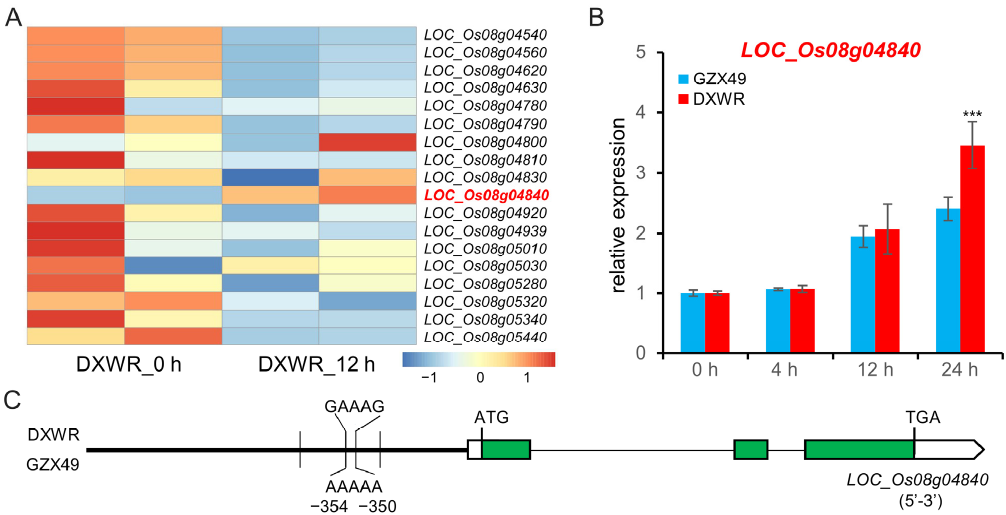
Figure 5. qSCT8 candidate gene analysis. ( A ) Clustering heat maps of the relative expression levels of genes within the qSCT8 localization interval determined using RNA-seq data. Standard scores (Z-scores) were used as the numerical signs to evaluate the standard deviations from the mean of the corresponding samples. ( B ) Expression levels of the LOC_Os08g04840 in GZX49 and DXWR after cold stress measured by qRT-PCR. The results were statistically analyzed using Student’s t -test (*** p < 0.005). ( C ) Sequence comparison of LOC_Os08g04840 among GZX49 and DXWR. Vertical bars represent